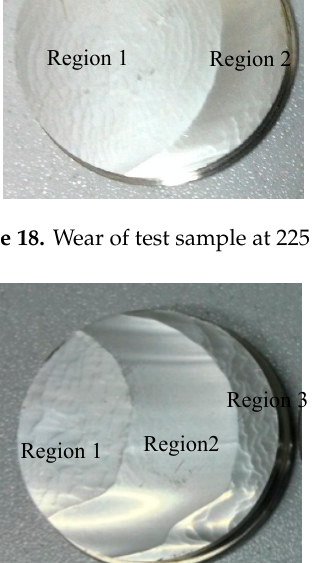
Figure 19. Wear of test sample at 316mm.